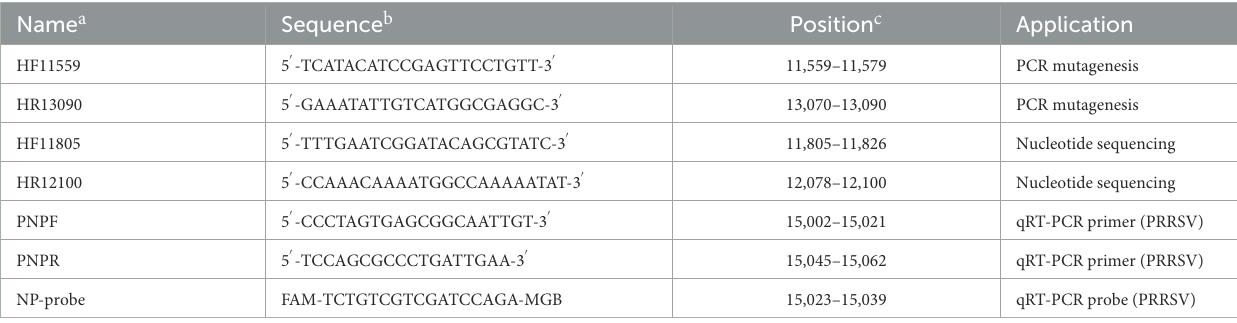
TABLE 1 Oligonucleotides used for RT-PCR and